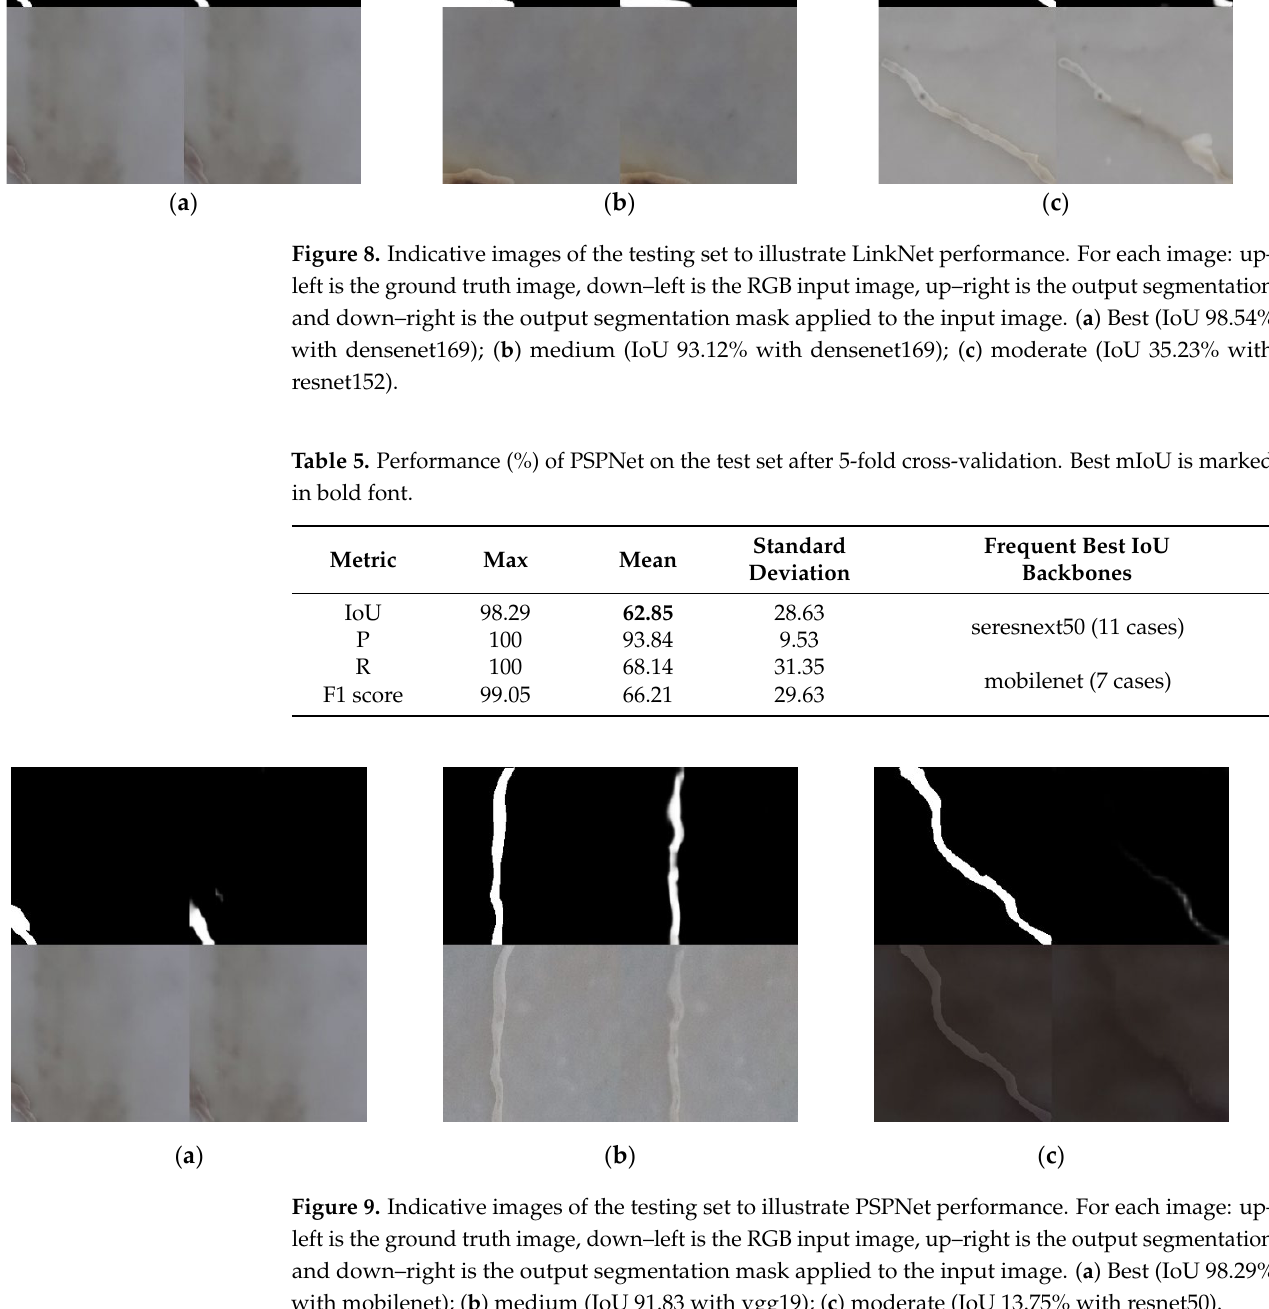
with mobilenet); ( b ) medium (IoU 91.83 with vgg19); ( c ) moderate (IoU 13.75% with